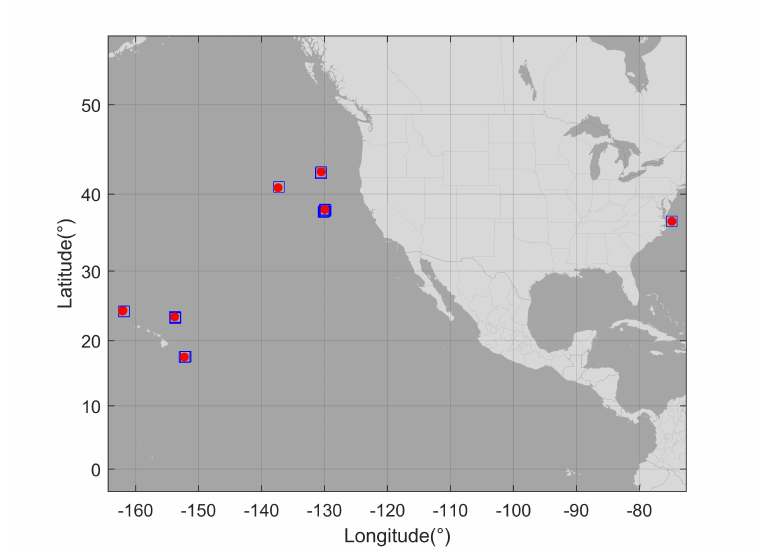
Figure 3. Distribution of NDBC buoys matching to TG2-InIRA. The red points denote the positions of the buoys while the blue squares represent the positions of the collocated TG2-InIRA data.